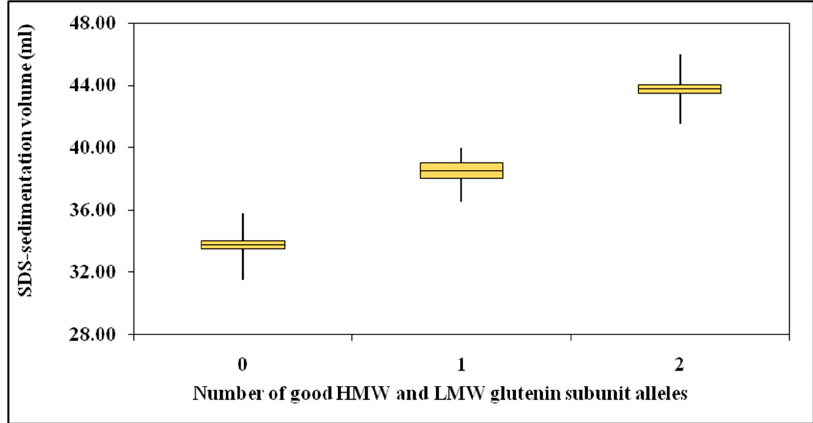
Figure 3. Cumulative e ff ects of HMWGS and LMWGS alleles on gluten strength.